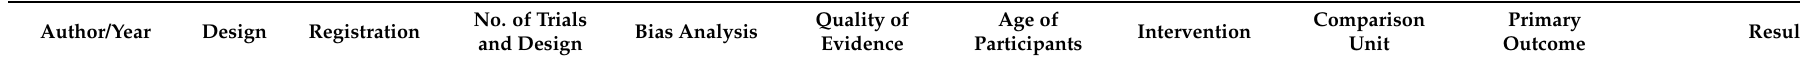
Table 4. Invasive